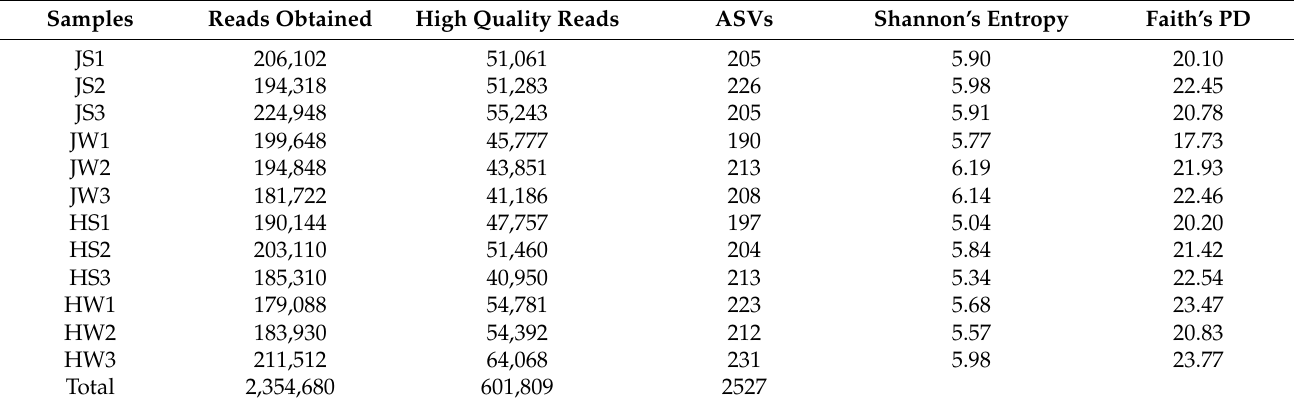
Table 1. The evaluation of 16S rRNA sequences in Jamaican (J) and house (H) crickets both surface (S) and whole-body (W)